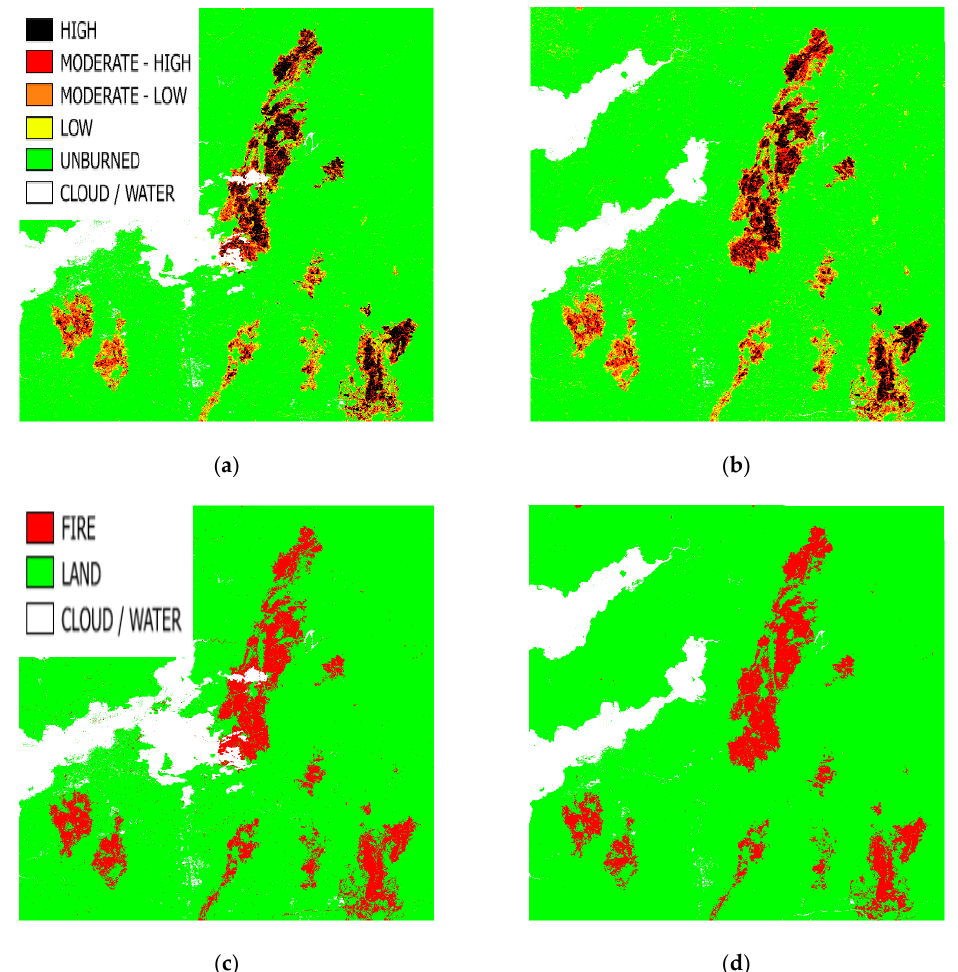
Figure 2. ( a ) Sentinel-2 dNBR image; ( b ) Landsat-8 dNBR image; ( c ) Sentinel-2 differences in normalized difference vegetation index (dNDVI) image; ( d ) Landsat-8 dNDVI image.